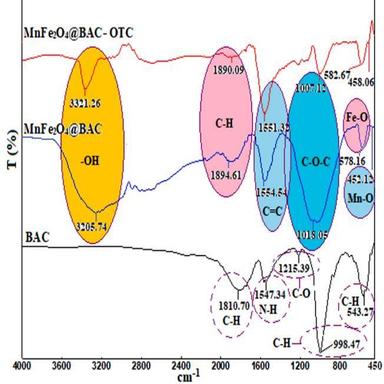
FTIR spectra of BAC and before and after sorption of OTC sorption of MnFe2O4@BAC.